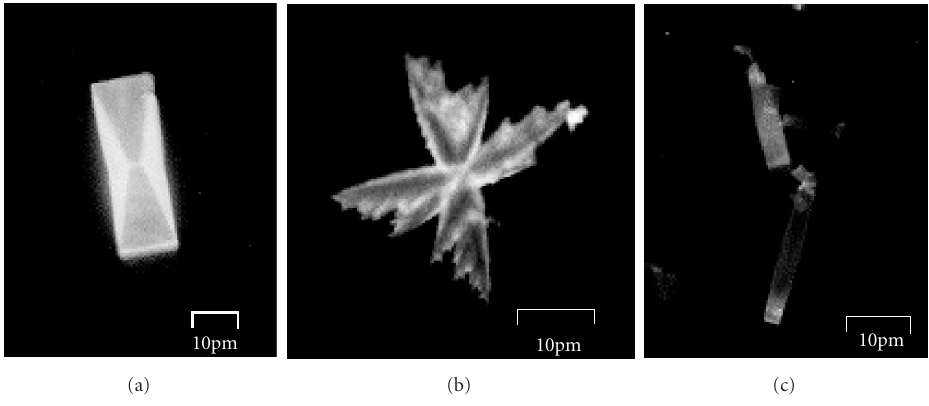
Figure 2: Fluorescence microscopy image of microcrystals of 1 grown in the presence of (a) poly(acrylic acid, sodium salt) (5 . 9 × 10 − 5 M); (b) poly(acrylamide) (4 . 1 × 10 − 7 M); and (c) calf thymus DNA (5 . 0 × 10 − 5 Mbp). Total dye concentration: 2 × 10 − 5 M.